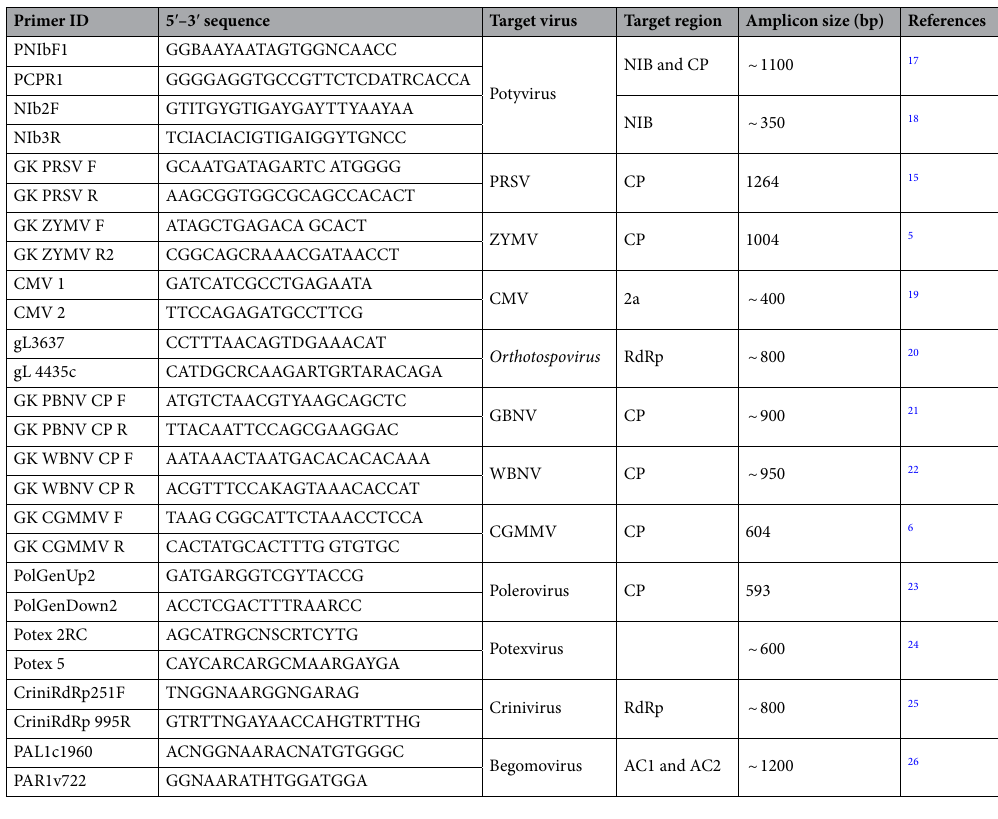
Table 4. Details of primers used in this